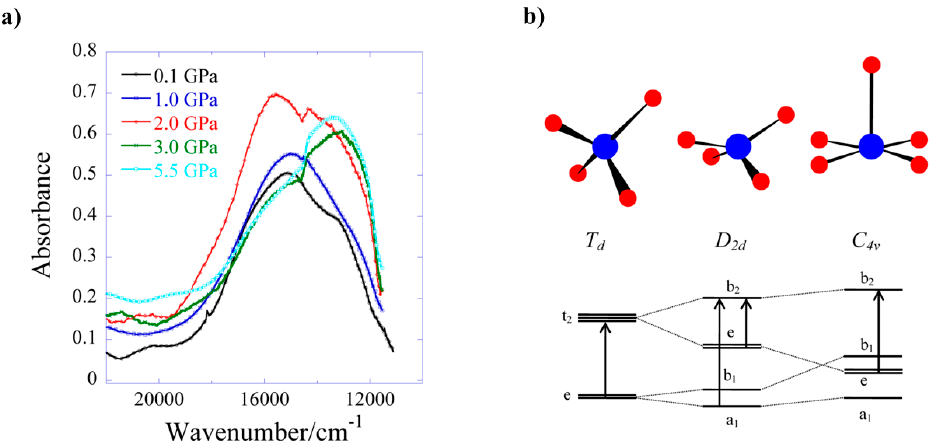
Figure 12. ( a ) Electronic absorption of complex 8 at different pressures (up to 5.5 GPa) at ambient temperature. ( b ) Correlation diagram showing the energy level structure of 4-coordinate Cu II from T d to D 2d , and 5-coordinate from D 2d to C 4v . The arrows indicate symmetry allowed transitions. The complexes [Cu 2 (OH) 2 (H 2 O) 2 (tmen) 2 ](ClO 4 ) 2 ( 9 , tmen = tetramethylethylenediamine),